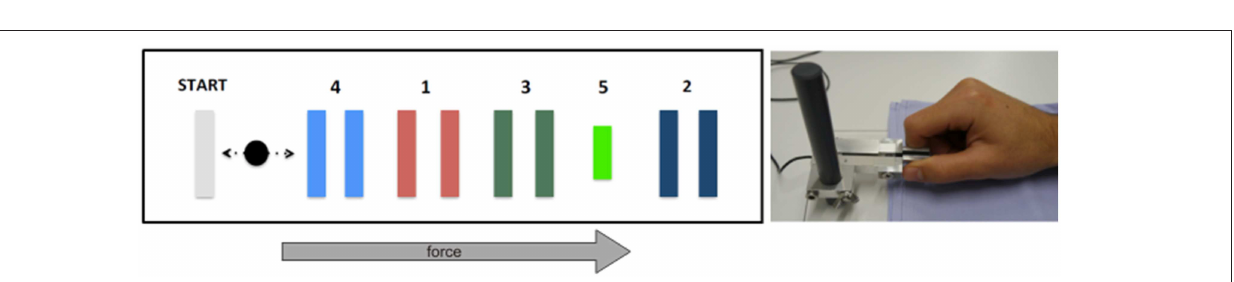
skill learning (Reis et al., 2009; Cantarero et al., 2013a,b). a force transducer with their right thumb and index